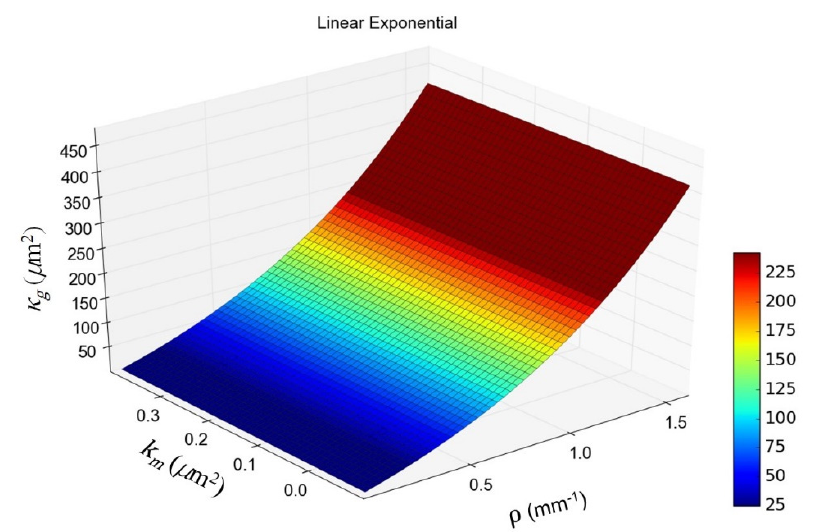
Figure 13. Equivalent permeability κ as a linear exponential function of fracture density ρ and matrix permeability k m . Note: The numerical results at each point represent the mean values calculated from three models with identical fracture densities.